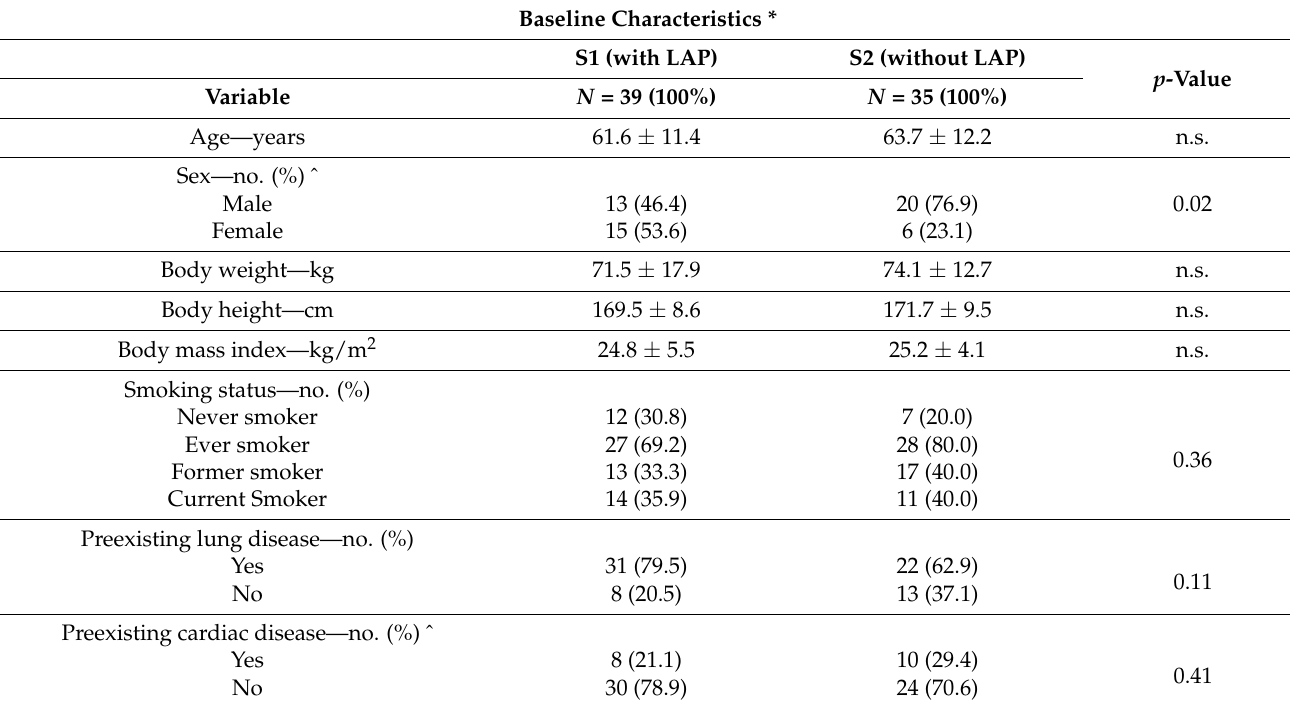
Table 1. Baseline characteristics for the two groups—S1 (Standard 1 with LAP) versus S2 (Standard 2, without LAP). Baseline Characteristics